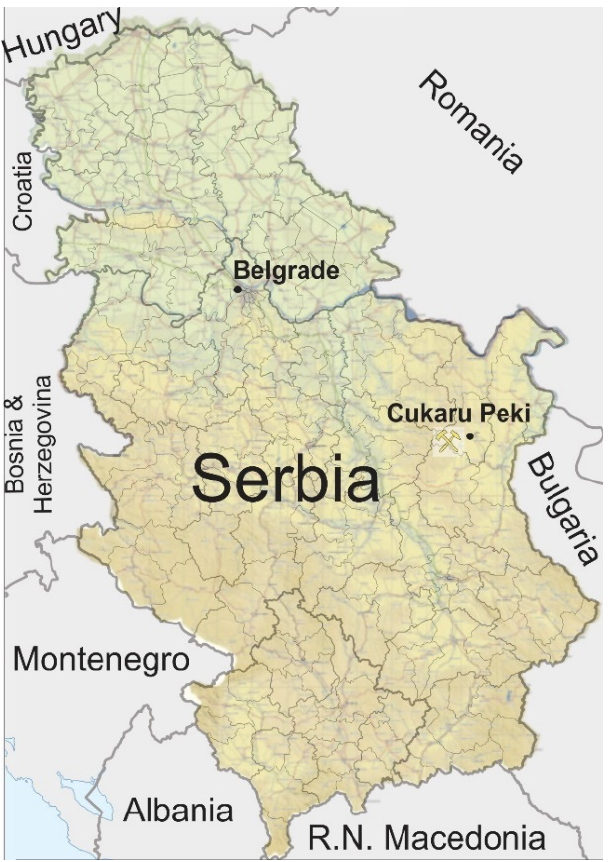
Figure 1. Map of Serbia with the location of the Cukaru Peki deposit (not to scale).